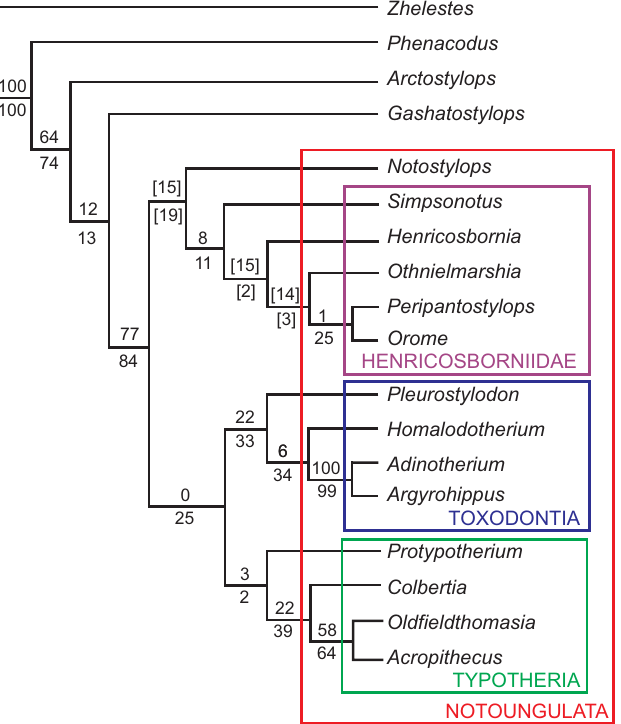
Fig. 6. Phylogenetic analysis. Resampling values of Bootstrap above the branches and Jacknife below the branches. Values between brackets are negative resampling